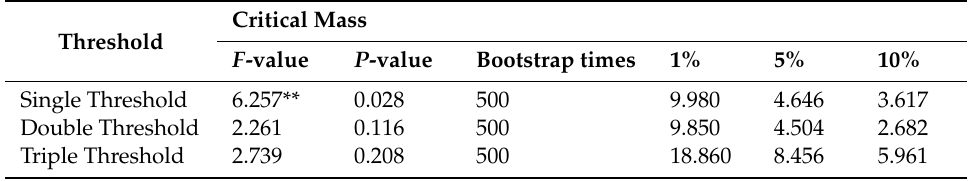
Table 2. Threshold significance test.